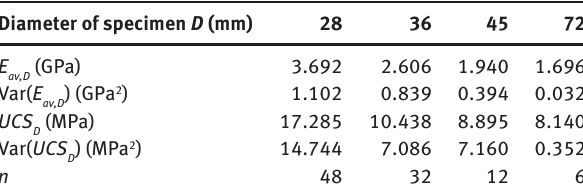
Table 2: The results of laboratory investigations for mortar speci- mens of different diameter D .